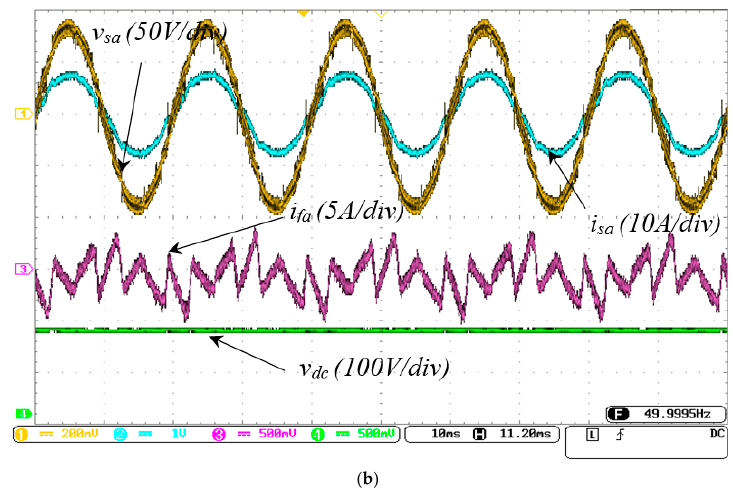
Figure 12. Main parameters of the system in steady state operation after using DPC ( a ) and MPPC-SVM ( b ). Figure 13 represents, from top to bottom: source voltage and source current, filter current, and DC bus voltage. As can be seen, before connecting the filter, the load current is totally supplied by the utility grid; as a result, the source voltage is affected by harmonic components in the supply